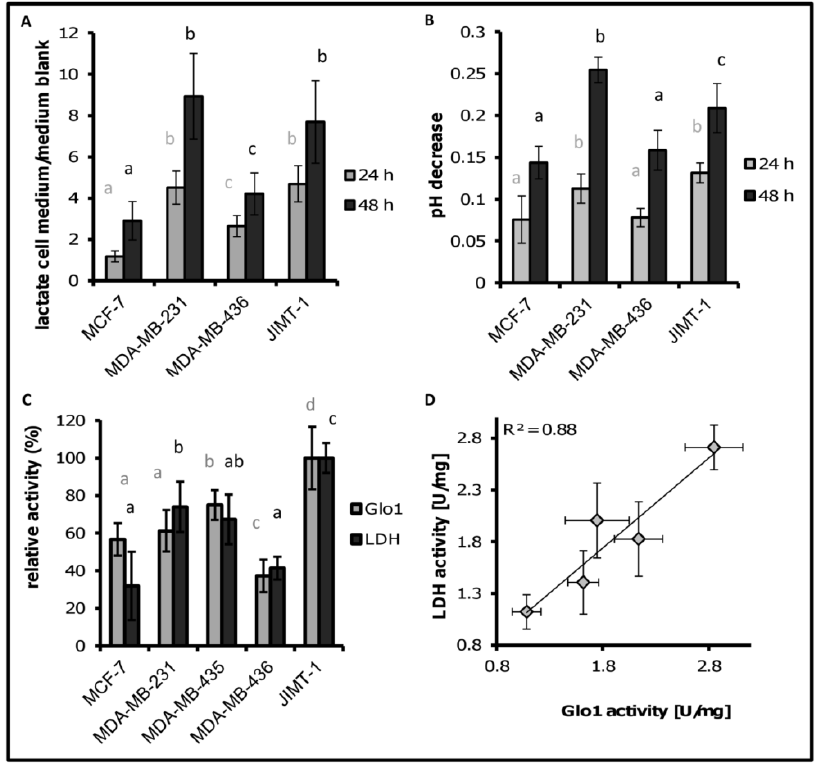
Figure 2C. The relative enzyme activity pattern of LDH correlated with the pattern of Glo1 (r = 0.94, p = 0.023, Figure 2D). Figure 2. ( A ) Lactate release for the cell lines. Signal ratios were calculated by dividing signals from medium samples with cells by the signal of medium blank measurements; ( B ) pH difference between medium blank and cultivation medium after 24 h and 48 h; ( C ) maximum normalized enzyme activities for LDH and Glo1 for the five cell lines; same letters indicate no significant difference, different letters = significant difference between cells with p < 0.05. n = 6 for lactic acid release, pH value and Glo1 activity, n = 4 for LDH activity; and ( D ) Correlation between LDH activity and Glo1 activity in